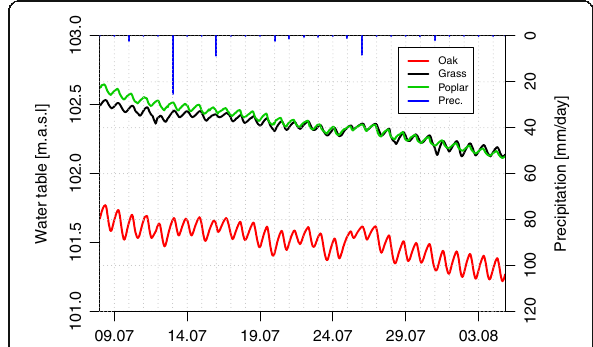
Fig. 5 Water table in meters above sea level under the three different vegetation types in summer of 2012